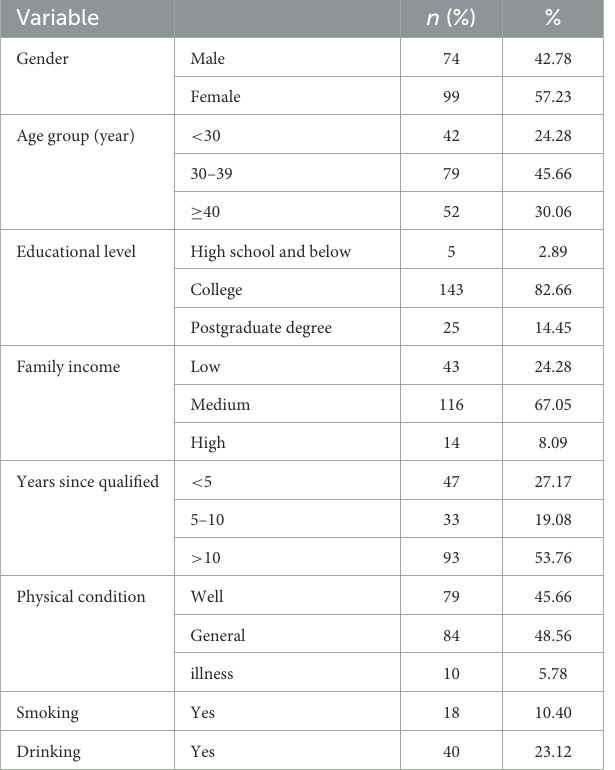
TABLE 1 Characteristics of participants of health professionals ( N = 173).